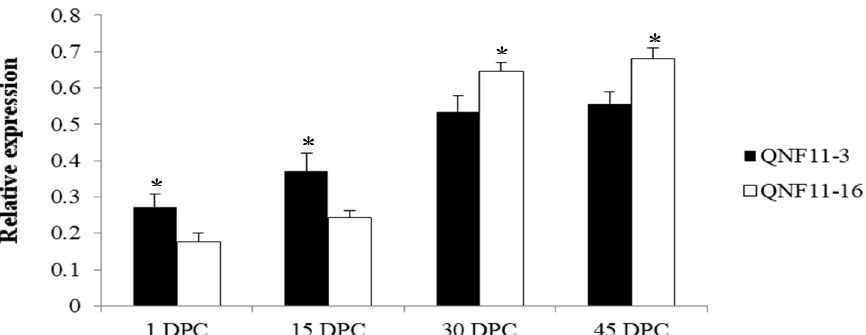
Figure 5. Expression levels of Bo4g024850 between QNF11-3 and QNF11-16 at different curd developmental stages. The X-axis represents the sampling period (days post curding, DPC). Error bars represent standard errors derived from three replications and asterisks represent significant differences (* p < 0.05).